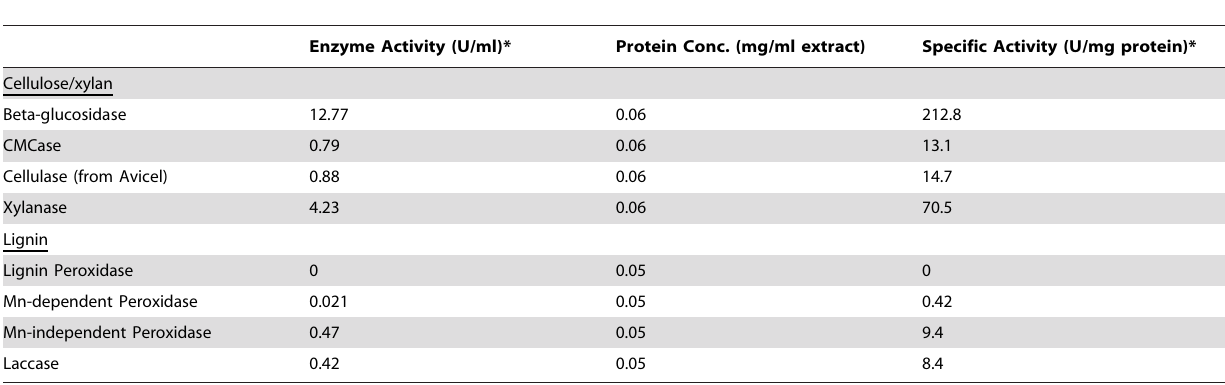
Figure 1. Enrichment of GO Molecular Function terms in proteomic analysis. Bar graph represents the ratio of % composition of term in proteomic data vs. % composition in the genome annotation. Values over 1 (dotted line) are overrepresented in the proteomic data. Red line illustrates the relative abundance of the GO term in the proteomic data. doi:10.1371/journal.pone.0032990.g001 Table 7. Verification of lignocellulytic activity of A. glabripennis derived F. solani solid wood culture extracts through in vitro